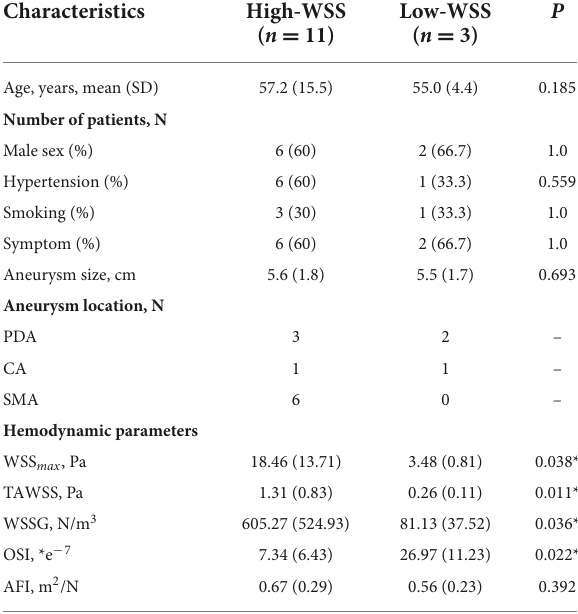
TABLE 1 Baseline characteristics of patients and